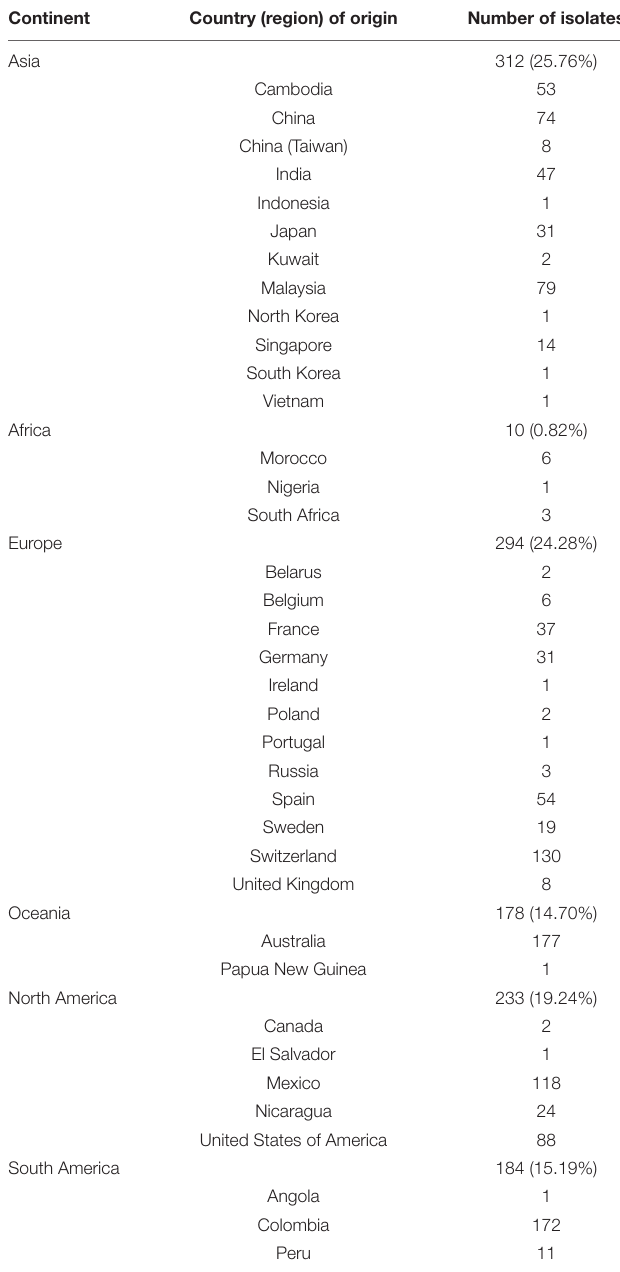
TABLE 1 | Summary of 1,211 H. pylor i